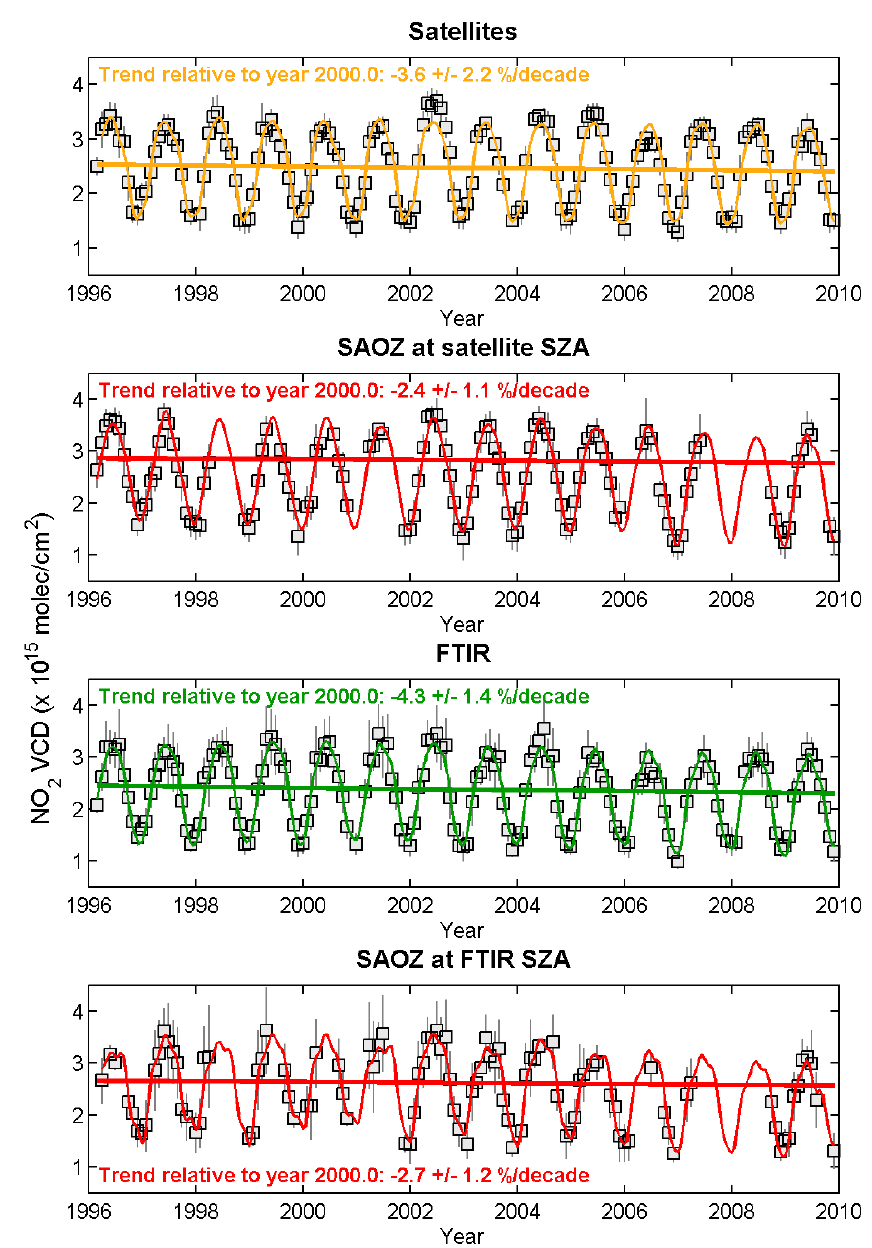
Figure 7: Results of the trend analysis over the 1996-2009 period using the satellites, SAOZ, and FTIR monthly mean NO 2 vertical column densities (VCD; grey squares). Twilight SAOZ columns are photochemically converted to the mean SZAs of the FTIR and satellite measurements. Colored lines correspond to the linear trend (thick line) and to the NO 2 columns recalculated using the multiple linear regression model (thin line). The error bars correspond to 1-sigma standard deviation.